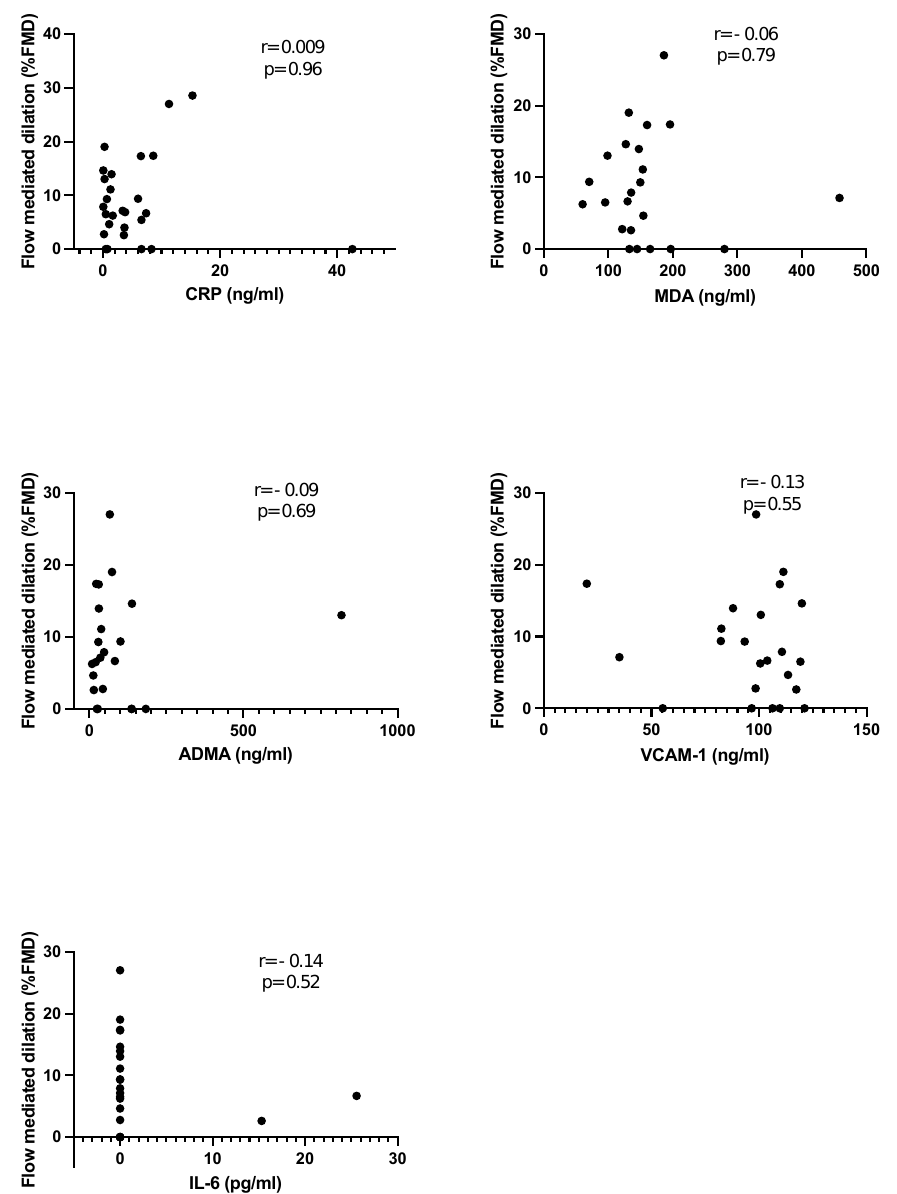
Table 6. Inflammation, oxidative stress, and endothelial dysfunction markers (mean ± SEM).